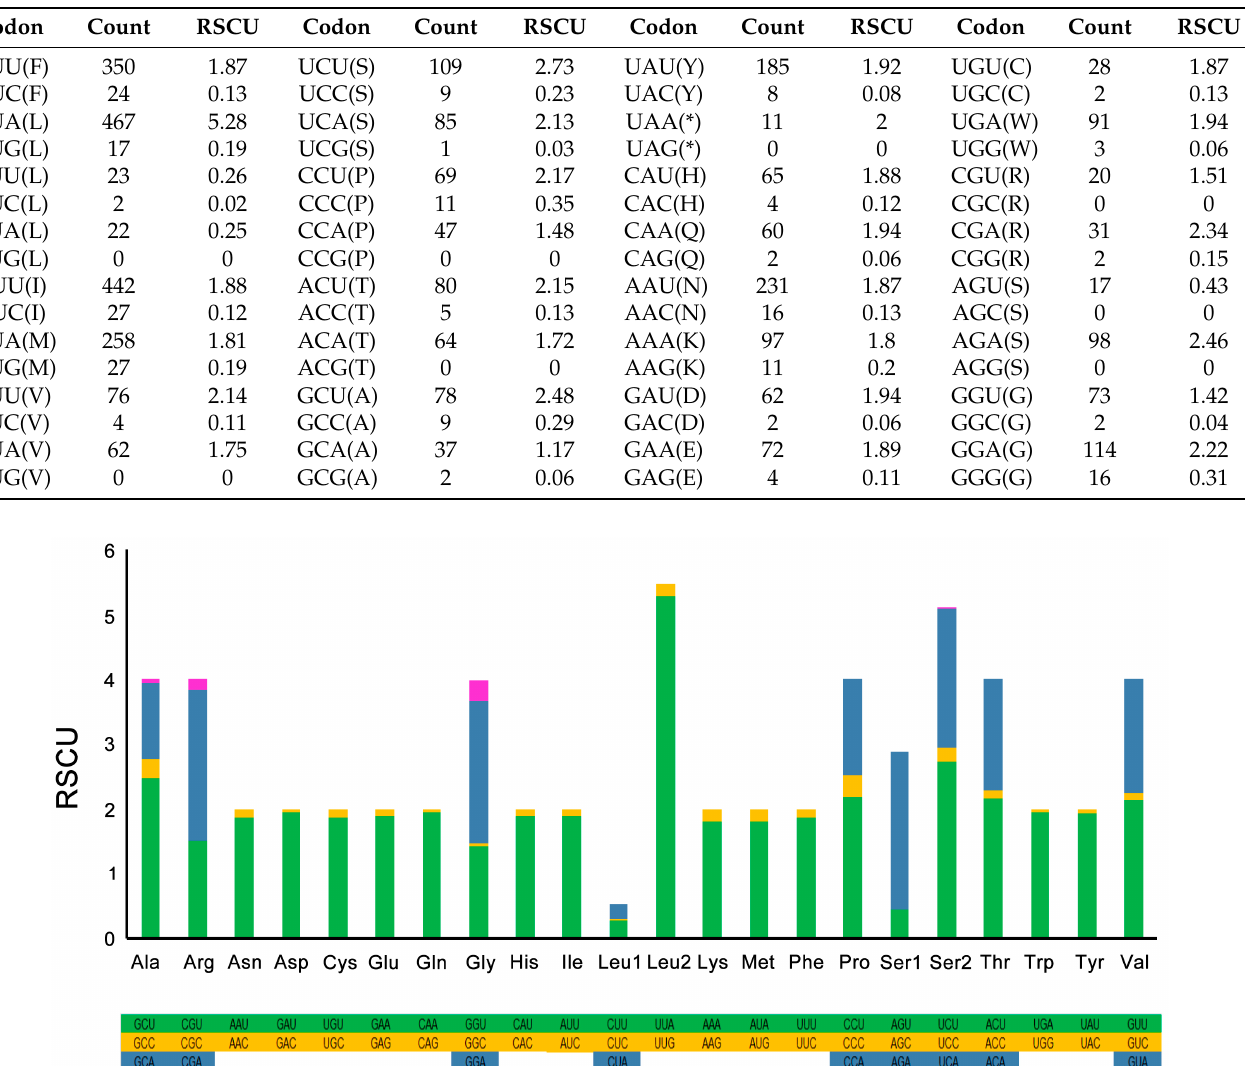
Table 4. Codon number and RSCU in the C. perspectalis mitochondrial PCGs. (* the termination codons).